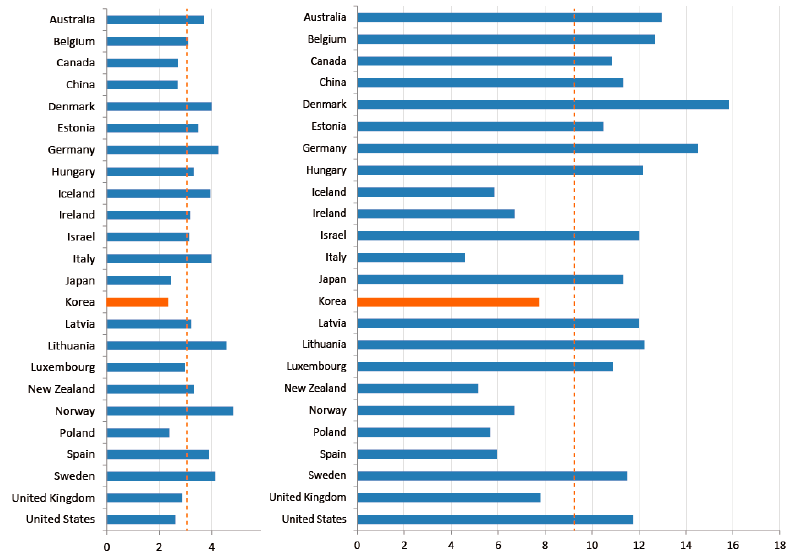
Figure 4. National health infrastructure of OECD countries. Note: Number of doctors/1000 inhabitants (left), number of nurses/1000 inhabitants (right). Source: OECD (Publicly available data. No copyright issue).